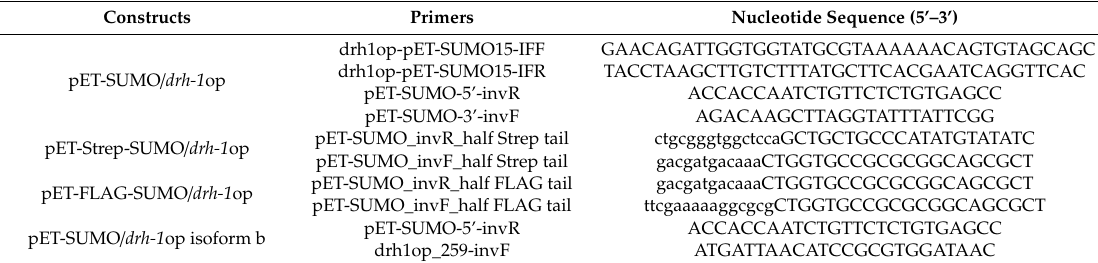
Table 1. Polymerase chain reaction primer sets used for plasmid construction. Lower-case letters in the nucleotide sequences correspond to the nucleotide sequences for the